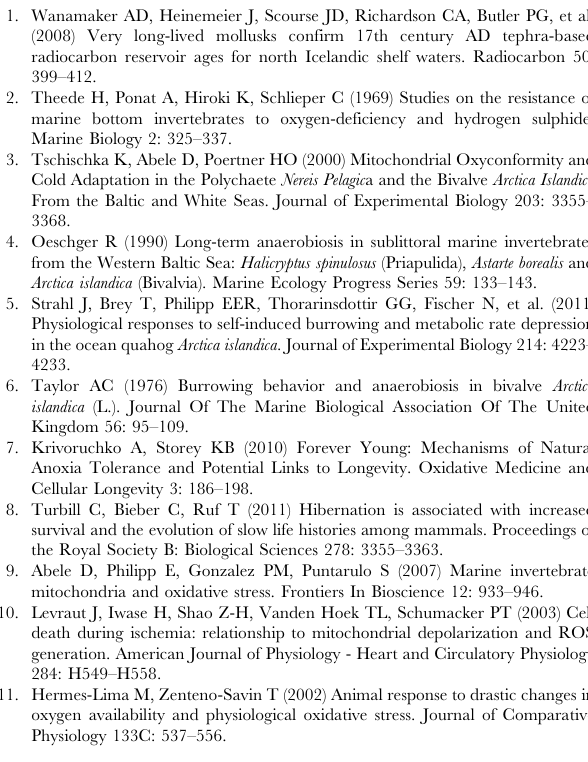
Table S5 Activities of the antioxidant enzymes catalase and glutathione peroxidase (GPx), as well as total glutathione concentrations (tGSH =GSH + GSSG) in gill tissue of Baltic Sea A. islandica individuals exposed for 3.5 days to Normoxia, Hypoxia and Anoxia and after 1 and 6 hours re-oxygenation. Data with similar symbols (*, # ) are significantly different from each other (p , 0.05, one-way ANOVA). Number of n per group = 6–8. Table S6 Concentration of protein carbonyls [nmol/ mg] and caspase activity [RLU/mg protein] in gill tissue of Baltic Sea A. islandica individuals exposed for 3.5 days to Normoxia, Hypoxia and Anoxia and after 1